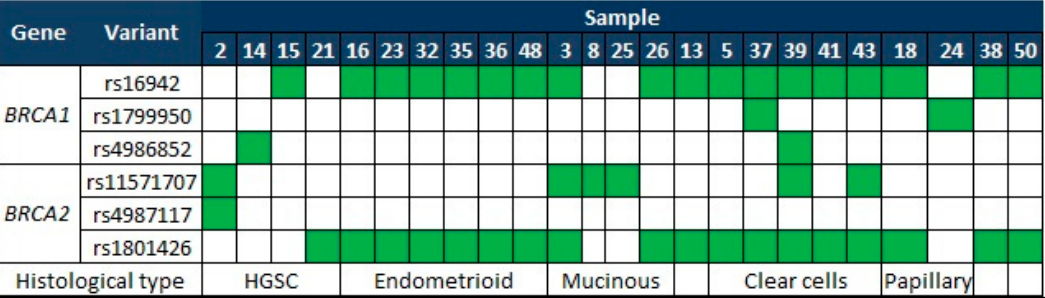
Figure 2. Genetic variants reported by Vaca-Paniagua [38] and our study. Samples: 13, Low-grade serous carcinoma; 38 Dysgerminoma; 50 Borderline tumor. HGSC: High-grade serous carcinoma. Figure 3 represents the global distributions of variants found in our study across both genes.